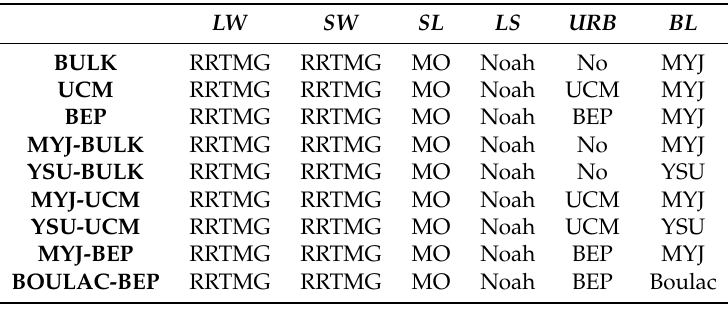
Table 1. Summary of the physics parameterizations used a